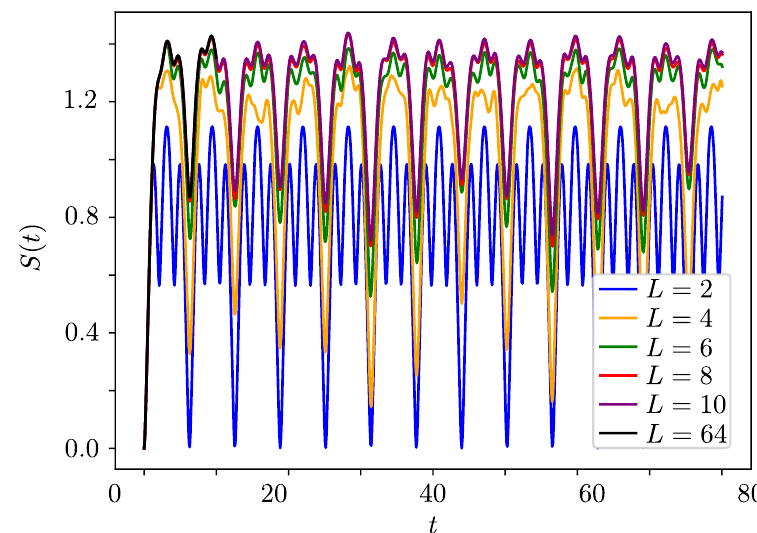
Figure 3: Time evolution of the entanglement entropy for L = 2...64 rungs after a quench from an initial product state of the form given in Eq. (2) with α = 0.5. The results are obtained by exact diagonalization for L ≤ 10 (up to 20 spins) and TEBD for L = 64 (only up to t = 10). The revivals in the time evolution are clearly visible even for long times and the maximum entropy saturates for L (cid:166) 6. The maximal entropy reached in the course of time is converged with system size and much smaller than ( L ) = L ln2 − 1 the Page entropy expected in ergodic systems ( S , which is about Page 2 43.86 for L =